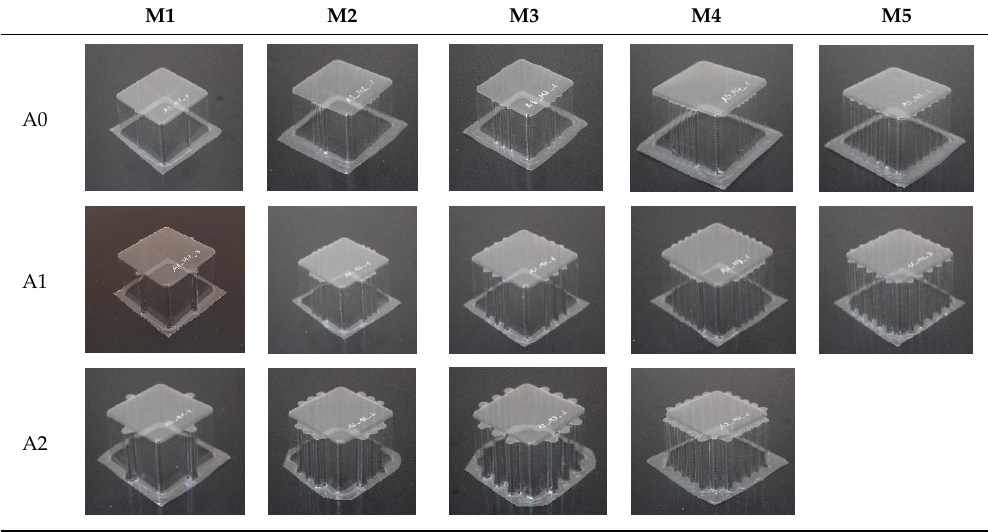
Figure 17. ( a ) Compression forces at stress yield; ( b ) Compression forces for a displacement of 0.5 mm.